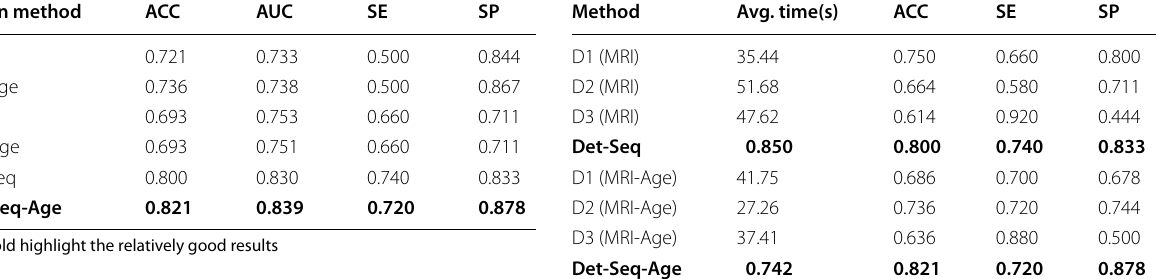
Table 3 Benign and Malignant tumor prediction results with different fusion methods on the test set Fusion method